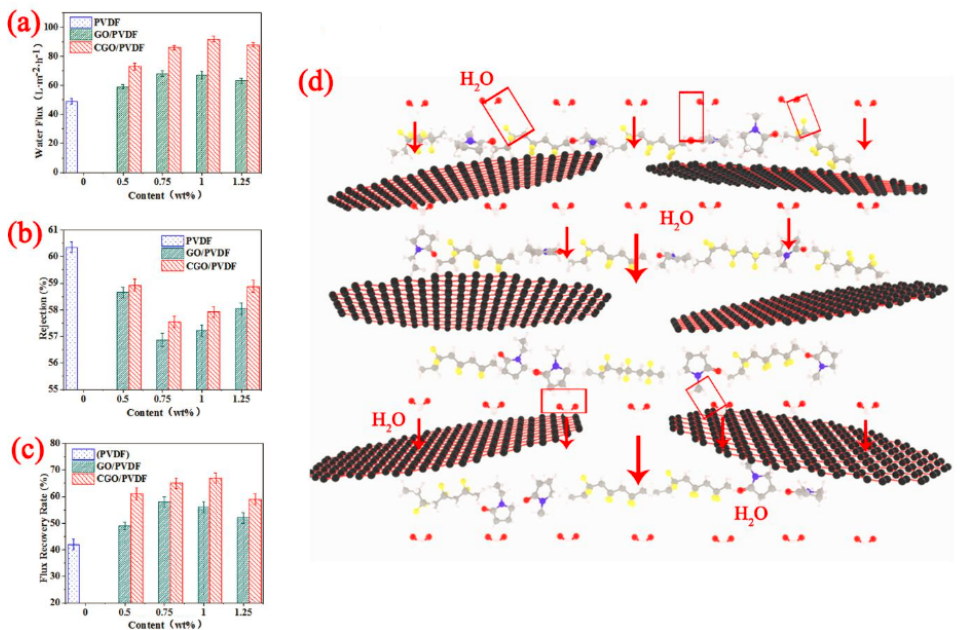
Figure 5. ( a ) Water fluxes, ( b ) BSA rejection rates, ( c ) flux recovery rates and ( d ) a schematic diagram of a composite ultrafiltration membrane.